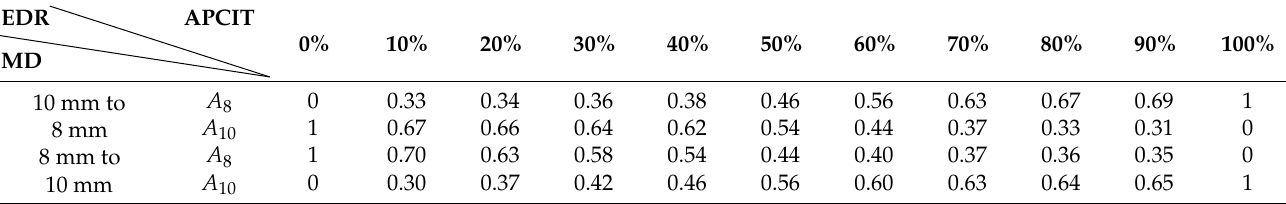
Table 5. EDR results of the transducer at different moving